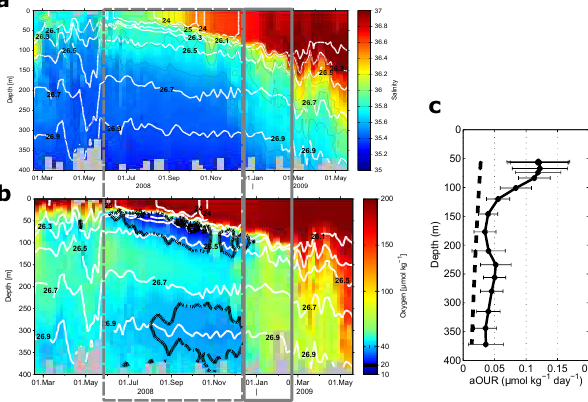
Figure 4. Time series of (a) salinity and (b) oxygen from profiling float data. The two grey boxes indicate the period when the float was trapped in the cyclonic eddy; these represent the isolated pe- riod (dashed box, left) and the non-isolated period (solid box, right). Potential density anomaly contours are shown as contour lines. (c) Vertical profile of the aOUR derived from successive dives during the period when the eddy was isolated. The thick broken line shows the background aOUR (Karstensen et al.,